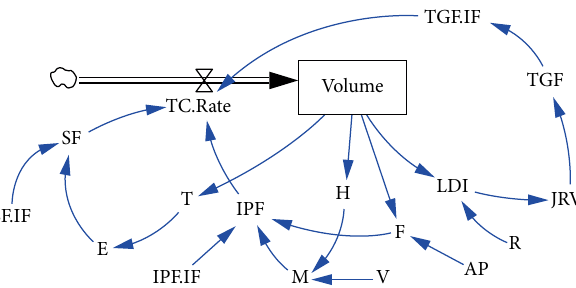
Figure 4: Modern tram passenger flow variable flow